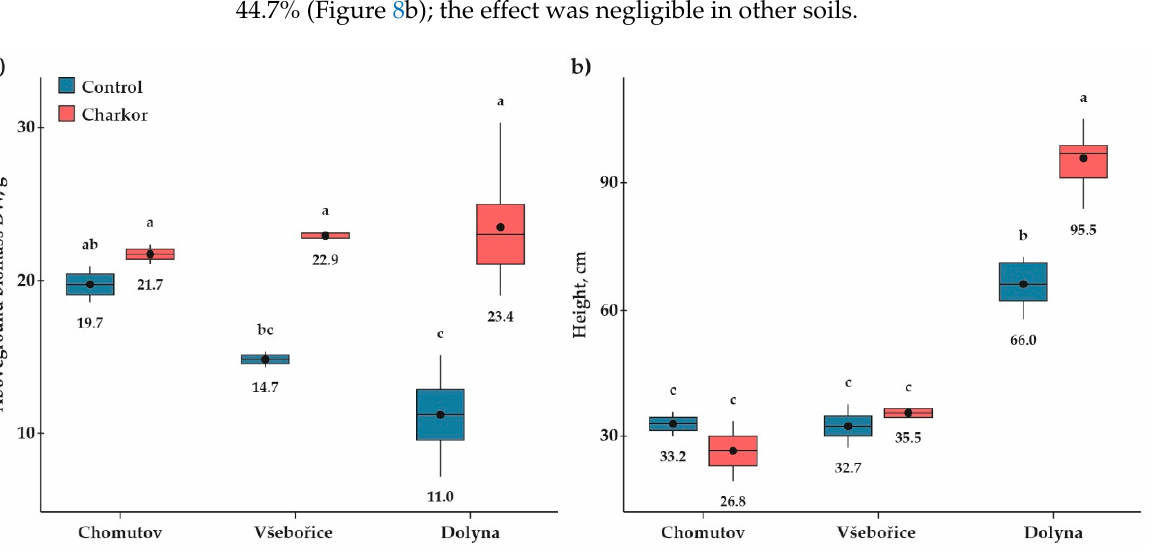
Figure 8. Influence of Charkor on biomass productivity in the different soils: ( a ) AGB DW; ( b ) plant height; ( c ) tillers quantity. Different letters indicate a significant difference between the values within one physiological parameter ( p < 0.05). Charkor positively affected M×g height only in the Dolyna soil: the increase was 44.7% (Figure 8b); the effect was negligible in other soils. The number of shoots in untreated plants cultivated in the compared soils did not show a significant difference (Figure 8c). Treatment with Charkor positively affected the number of shoots; however, a significant difference was found only in the Chomutov soil (Figure 8c). 4. Conclusions It can be concluded that the PGR Kamethur is more beneficial for yielding higher biomass during M×g cultivation in the more contaminated Všebo ř ice soil, while Charkor can be used to reduce the uptake of potentially toxic elements (PTEs) to AGB in differently contaminated soils. The PGR Charkor increased the accumulation of elements essential for plant devel- opment (EEs) in leaves and decreased them in stems. The application of PGRs to plants cultivated in more contaminated soil resulted in an inhibition of EEs’ accumulation in leaves, while their accumulation in stems was quite contradictory. When M×g was culti- vated in the less contaminated Chomutov soil, the application of PGRs increased the ac-